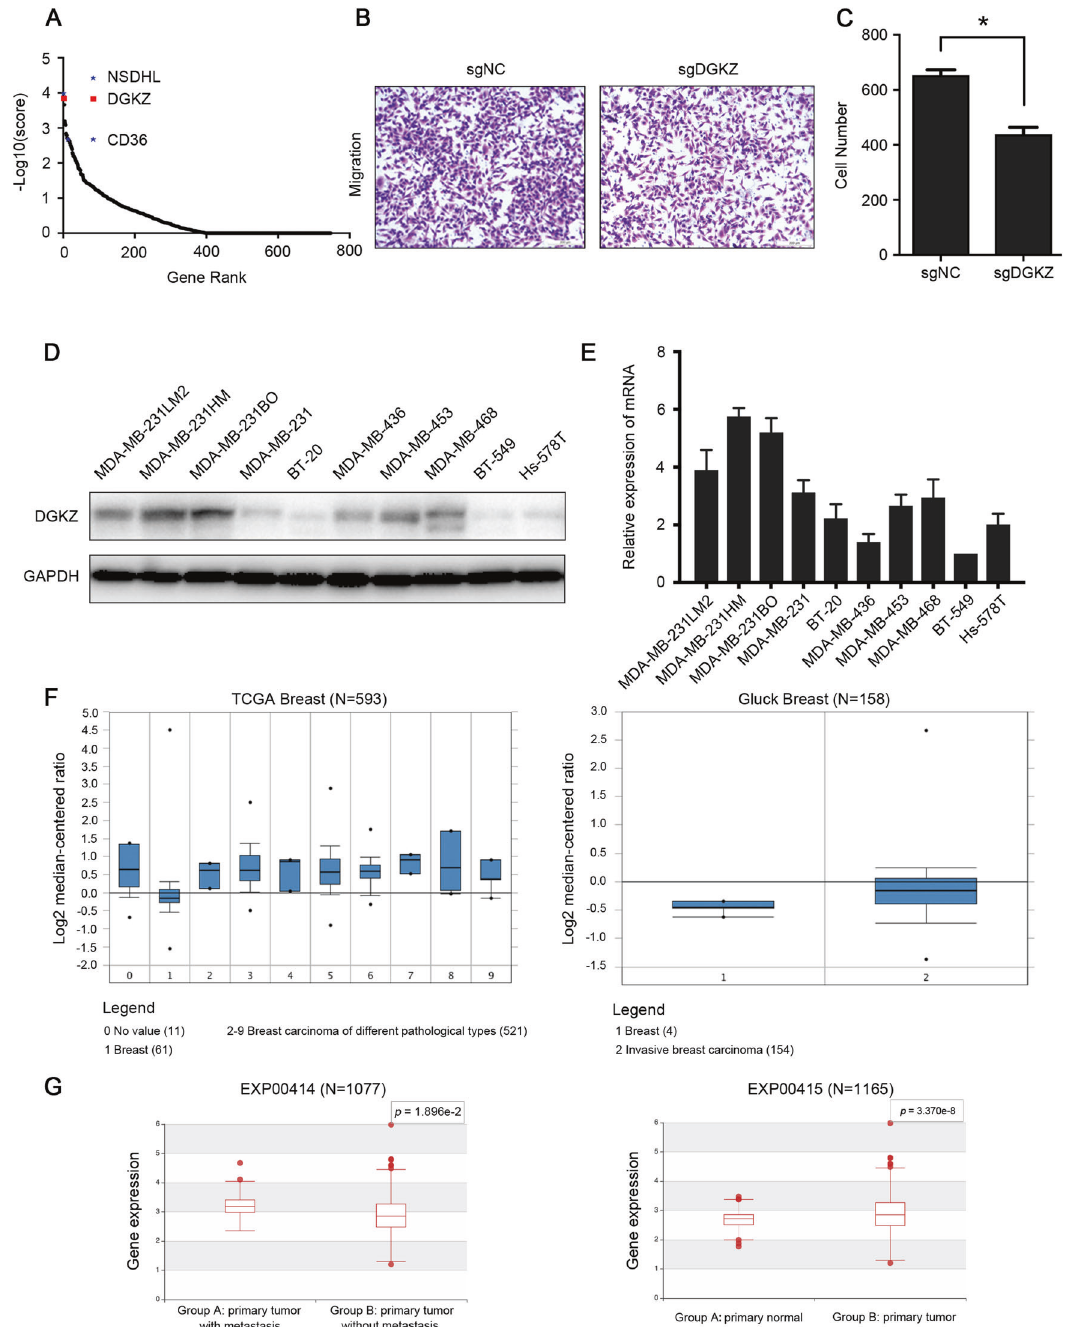
Fig. 1 DGKZ is upregulated in highly metastatic TNBC cells. A Explicit oncogenes NSDHL and CD36 were enriched in the negative selected gene sequencing, and DGKZ was located in the front place in the sequencing. B The change in migration ef fi ciency was analyzed by transwell assay in vitro after DGKZ was knocked out in the negative selected gene sequencing. C The histogram of the number of migrated cells in section B . D – E The protein and mRNA expression of DGKZ in TNBC cell lines (protein expression of DGKZ in MDA-MB-231 and mRNA expression of DGKZ in BT-549 cell as the reference). F Analysis of DGKZ expression in multiple subtypes of human breast cancer in the Oncomine database. G Analysis of DGKZ expression in primary normal breast tissues, primary tumor tissues, and primary tumor tissues with/ without metastasis in the Human Cancer Metastasis Database (HCMDB). The data represent the mean ± SD of three independent experiments. Bars, ±SD; * p < 0.05. in catalyzing the conversion of diacylglycerol (DAG) to phospha- [15]. We also found that diacylglycerol kinase ζ (DGKZ), one of tidic acid (PA) [16, 17]. DAG and PA are members of a class of the other candidate genes, might be associated with lipid molecules with unique biological functions that can work as metastasis. metabolic intermediates, basic components of bio fi lms, or The protein encoded by the DGKZ gene belongs to the second messengers [18]. Currently, the role of DGKZ in TNBC eukaryotic diacylglycerol kinases (DGK) family, which is involved Cell Death and Disease (2022)